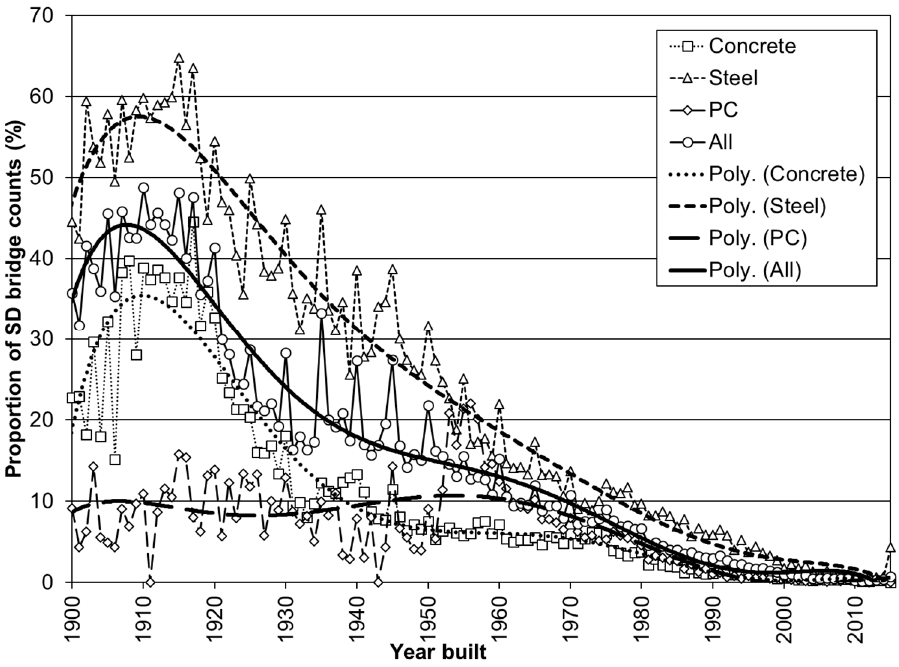
Figure 6. Distribution of the proportion of structurally deficient bridges.